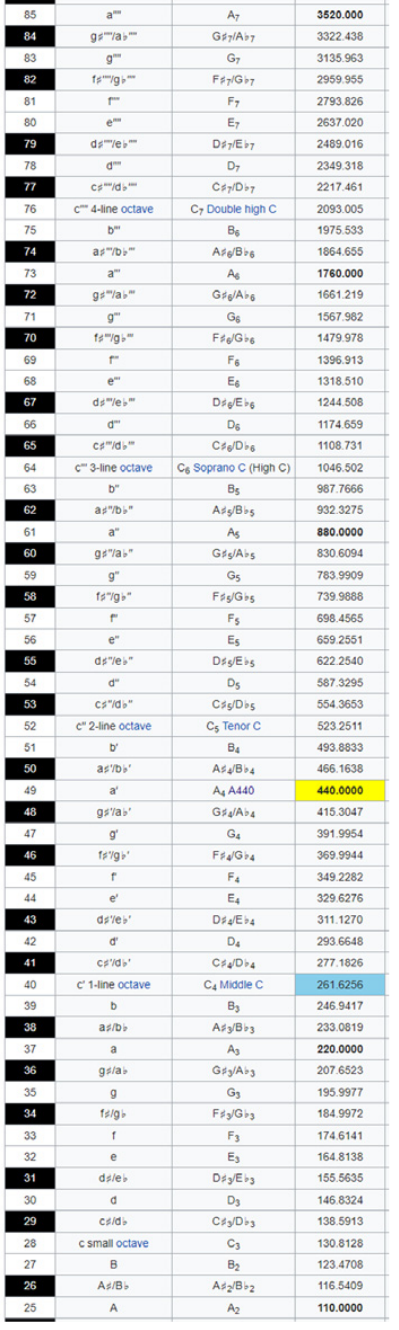
Figure 3. Relationship between musical notations and physical frequencies for five octaves between A2 and A7. 1st column: key number on a keyboard, 2nd column: Helmholtz’s notation. 3rd column: English notation. Right : corresponding frequencies in equal-tempered intonation. (Figure source: Wikipedia.)